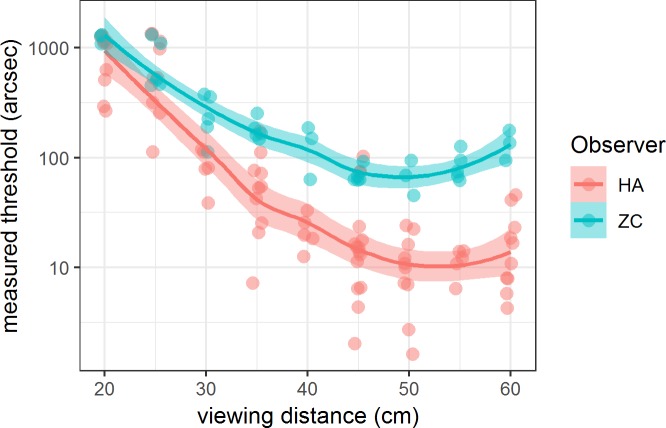
Measured thresholds for two observers as a function of viewing distance. Symbols show measured thresholds (each from at least 20 nonpractice trials), slightly jittered to avoid overlap. Lines show trend obtained by loess smoothing; ribbon shows 95% confidence interval.